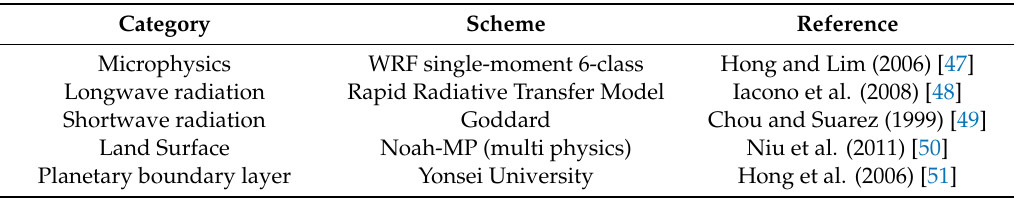
Table 5. List of the physics schemes used in the WRF-ARW configuration and applied to all